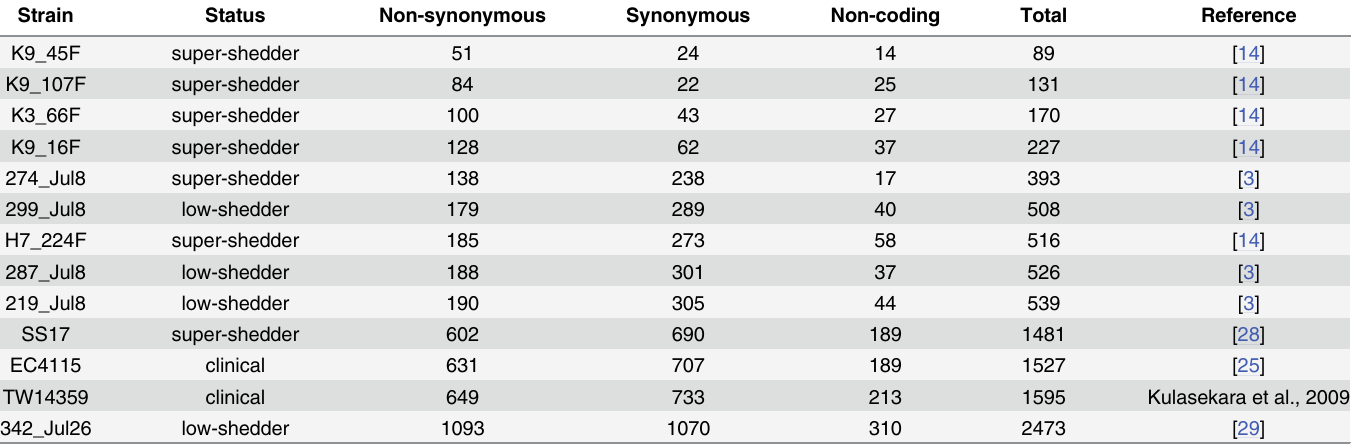
Table 1. Number of non-synonymous SNPs, synonymous SNP and non-coding regions among super-shedding ( n = 6), low-shedding Escherichia coli O157:H7 isolates ( n = 4) and other fully closed reference genomes when compared to